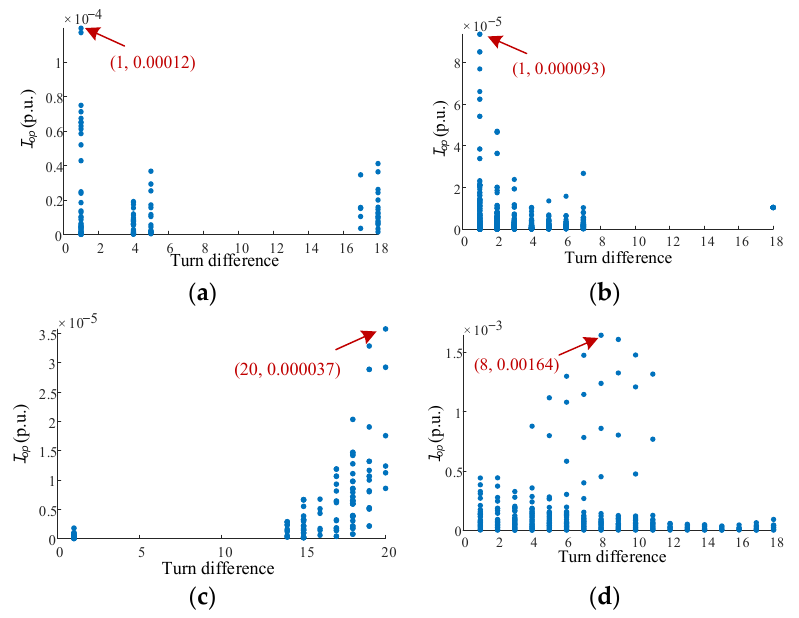
Figure 16. When s = 0.1, the simulation results of all possible internal short ‐ circuit faults in stator windings: ( a ) in ‐ slot faults; ( b ) end faults in the same branch with different short turns; ( c ) end faults between two branches in the same phase; ( d ) end faults between phases.